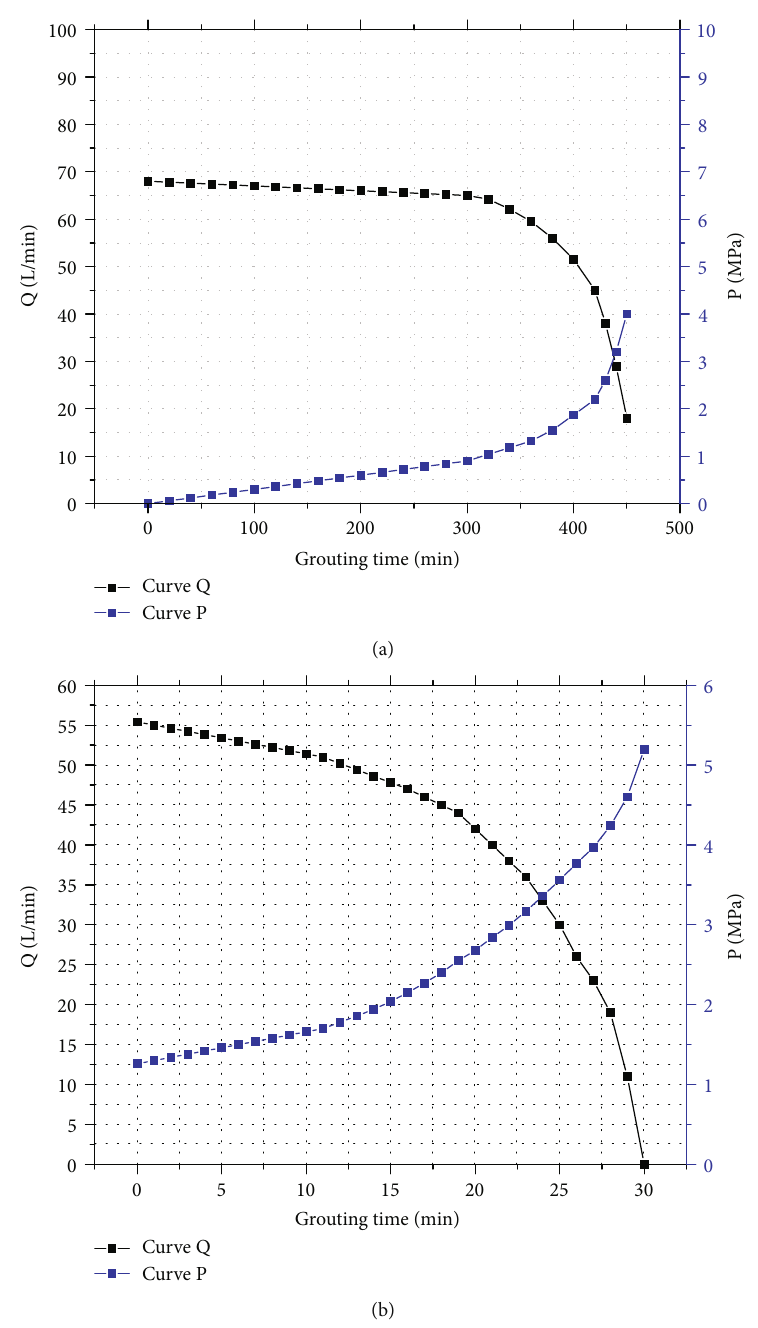
Figure 14: P-Q-T curve: (a) early stage and (b) late